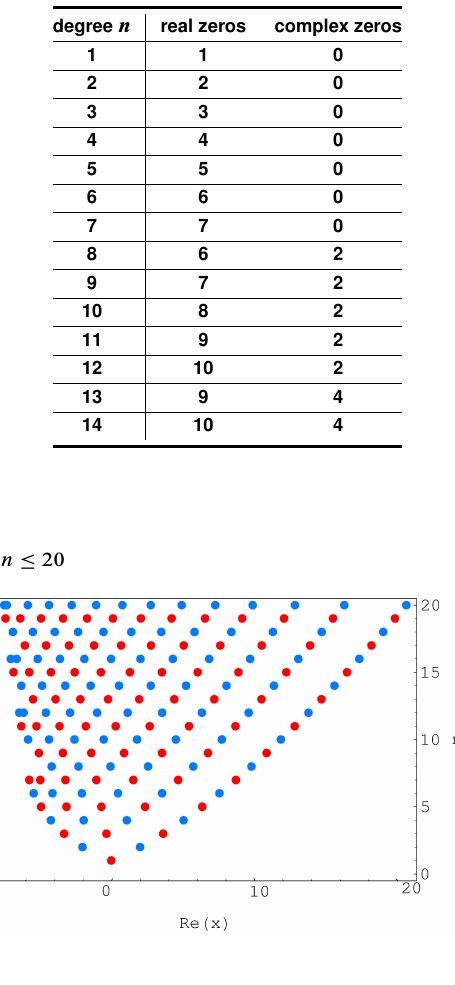
We observe a remarkably regular structure of the complex roots of the generalized Bell polynomials B n .x; (cid:21)/ . We